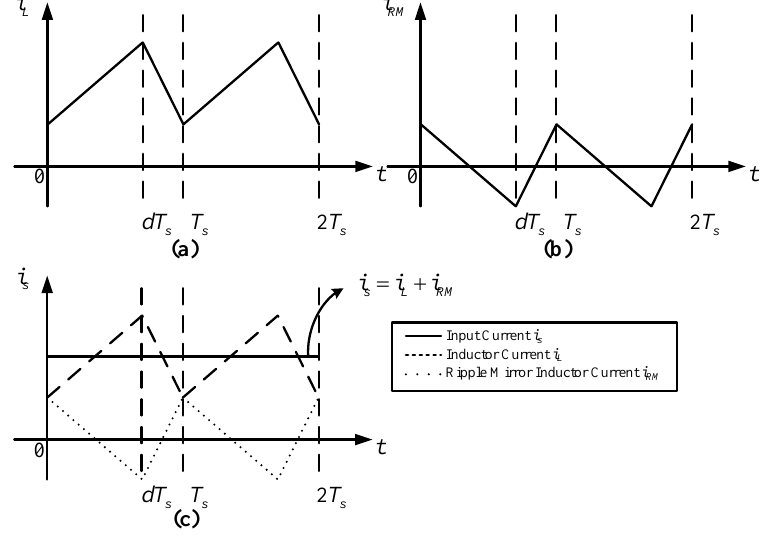
Figure 2. Steady-state current waveforms of the proposed converter ( a ) inductor current i L ; ( b ) RM (Ripple Mirror) inductor current i LRM and ( c ) input current i s